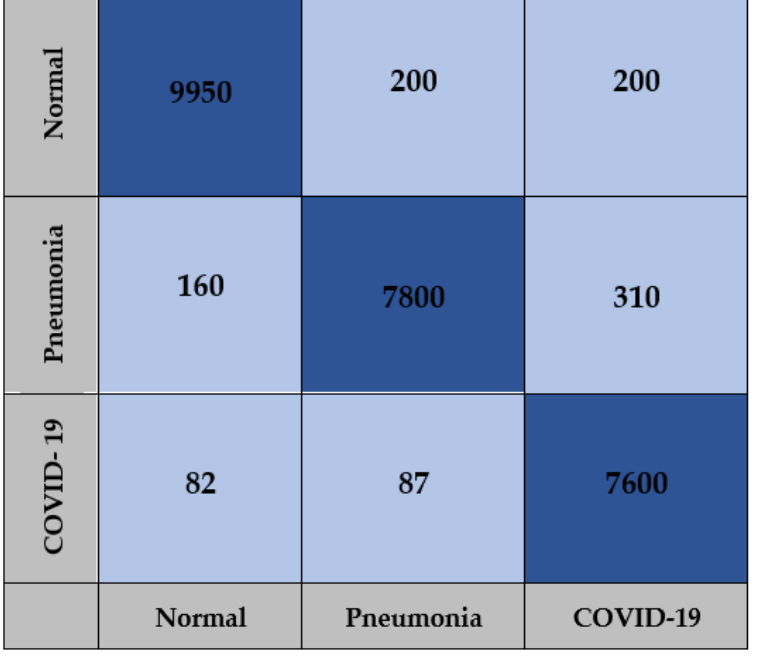
Figure 9. Confusion matrix for AlexNet model.